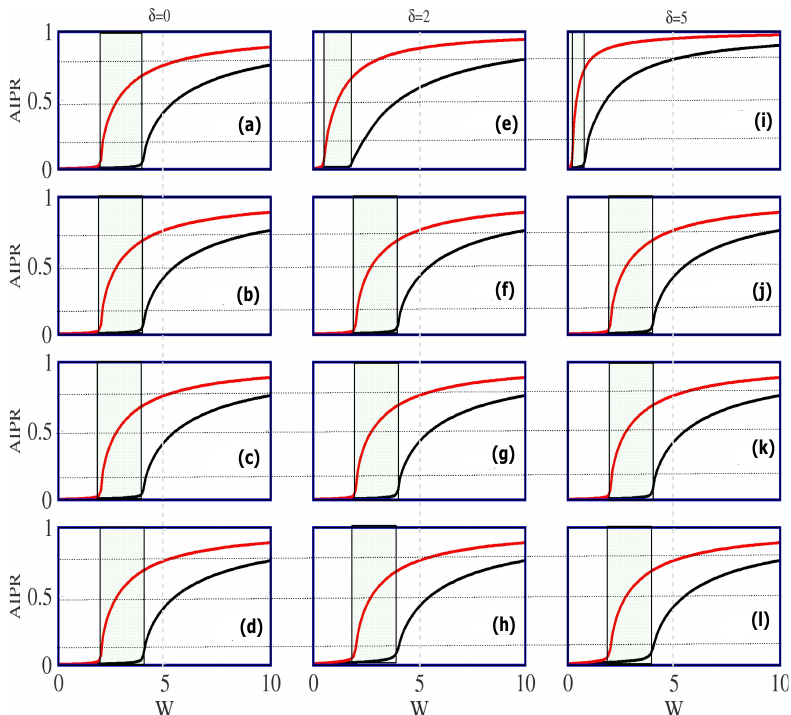
Figure 3. (Color online). Dependence of the average inverse participation ratio with the Aubry– André–Harper modulation strength W , where in each spectrum, the black and red lines are associated with chain-1 and chain-2, respectively. The results are shown ( a – l ) for three typical δ values (placed in the three different rows), where the four different rows (top to bottom) correspond to the BT-I, IT-I, IT-II and BT-II ladders, respectively. The light-shaded region denotes the mixed-phase window, that is tuned by means of δ